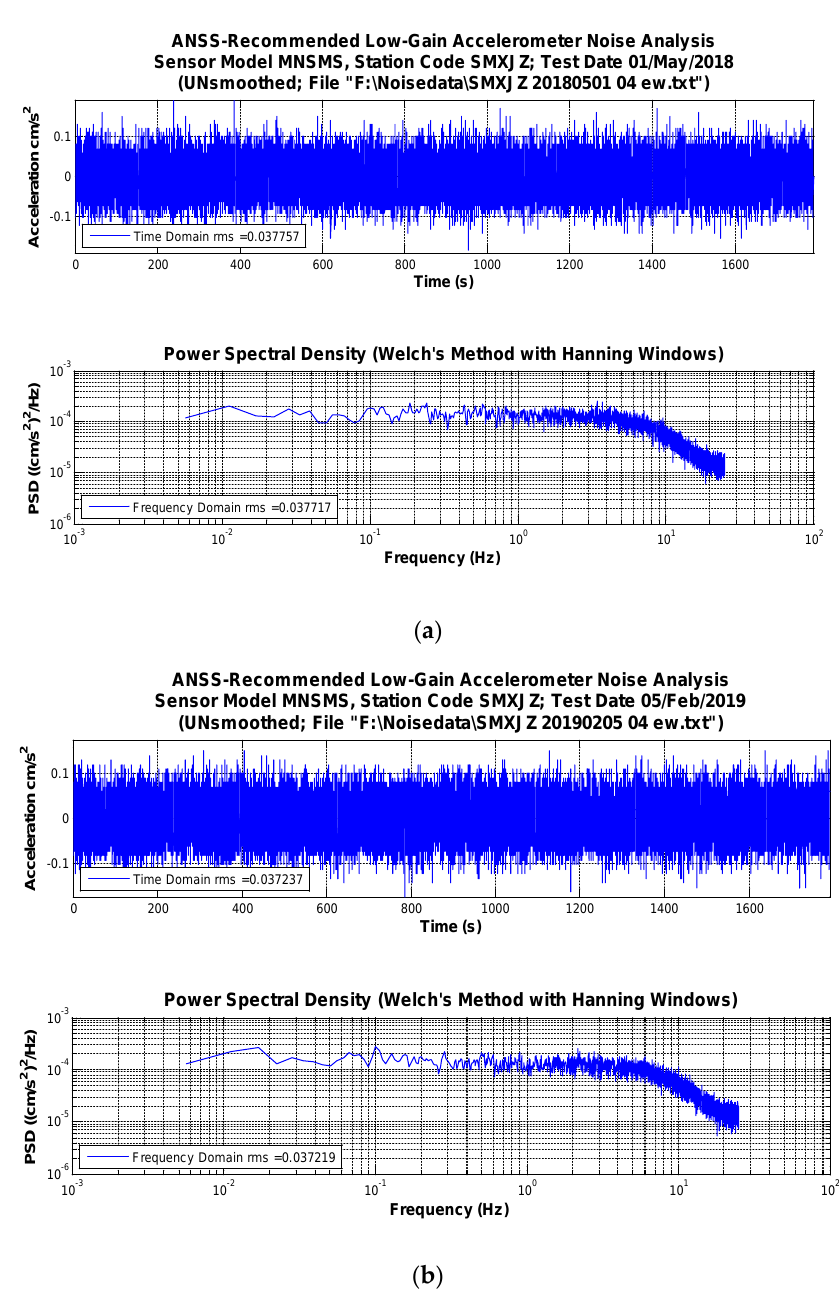
Figure 3. Noise signal of the sensor SMXJZ in time domain and their RMS, PSD calculated: ( a ) Analysis results of the noise signal obtained on May 1, 2018; ( b ) Analysis results of the noise signal obtained on February 5, 2019.